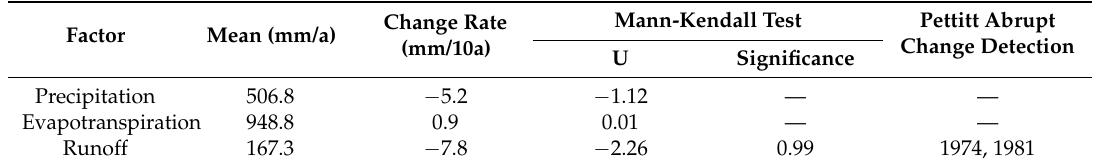
Table 1. Pettitt change point analysis of annual precipitation, potential evapotranspiration, and runoff in the Nenjiang River basin.